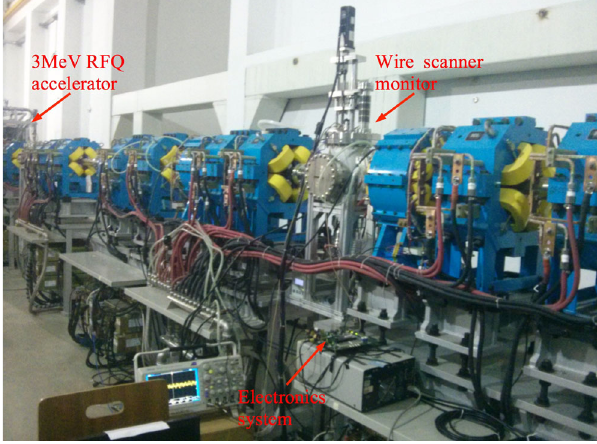
FIG. 9. Experimental setup of the wire scanner monitor.